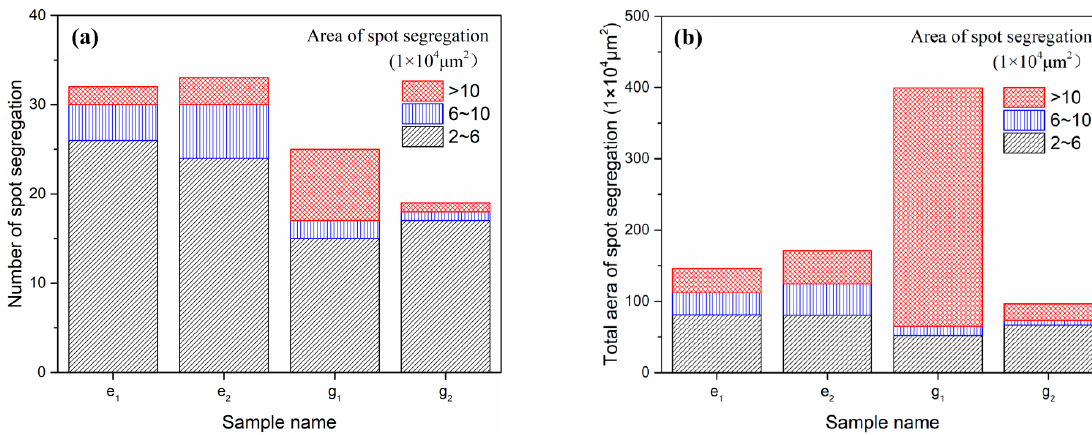
Figure 14. Distribution of spot segregation ( a ) number, ( b ) total area.